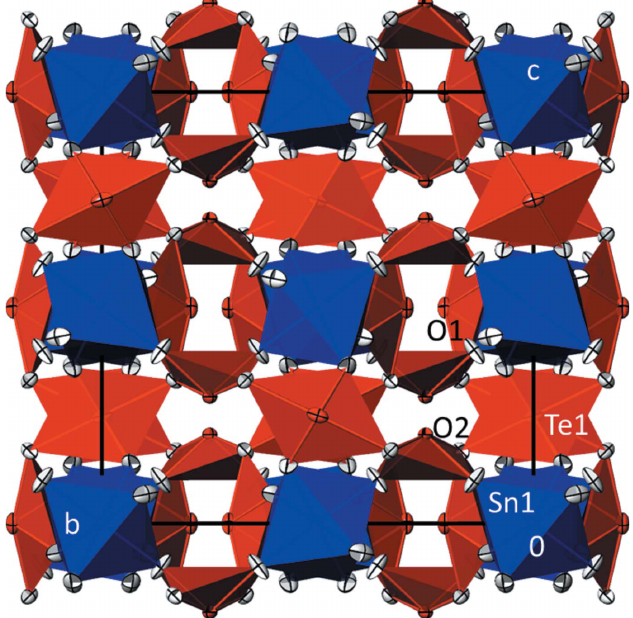
Figure 1 Figure 2 The coordination environment around Te1. Displacement ellipsoids are drawn at the 90% probability level; the electron lone pair is given as a The crystal structure of SnTe 3 O 8 in polyhedral representation, showing a green sphere of arbitrary radius. [Symmetry codes: (v) – z + 1 projection along [100]. Displacement ellipsoids are as in Fig. 1; [TeO 4 ] , x –1/2, y ; 2 polyhedra are red, [SnO 6 ] octahedra are blue. (vii) (cid:5) z + 1 , (cid:5) x + 1 , (cid:5) y + 1 ; (viii) x , (cid:5) y , (cid:5) z + 1 2 2 2 2